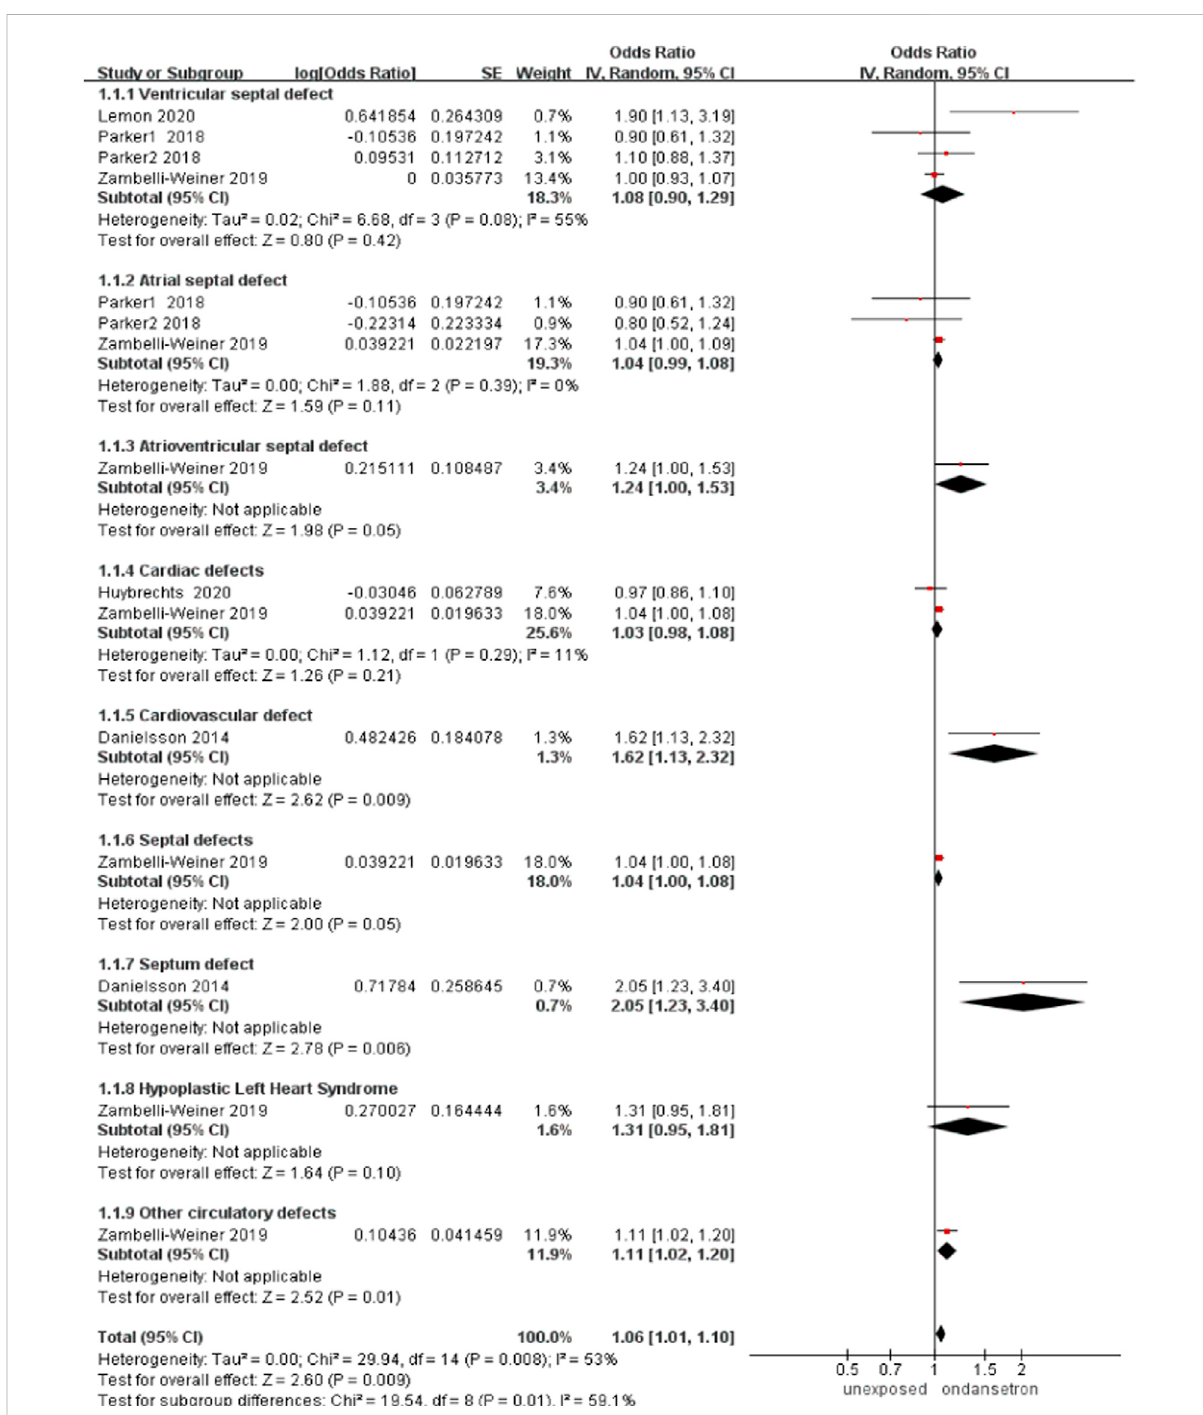
FIGURE 2 Forest plot of cardiac